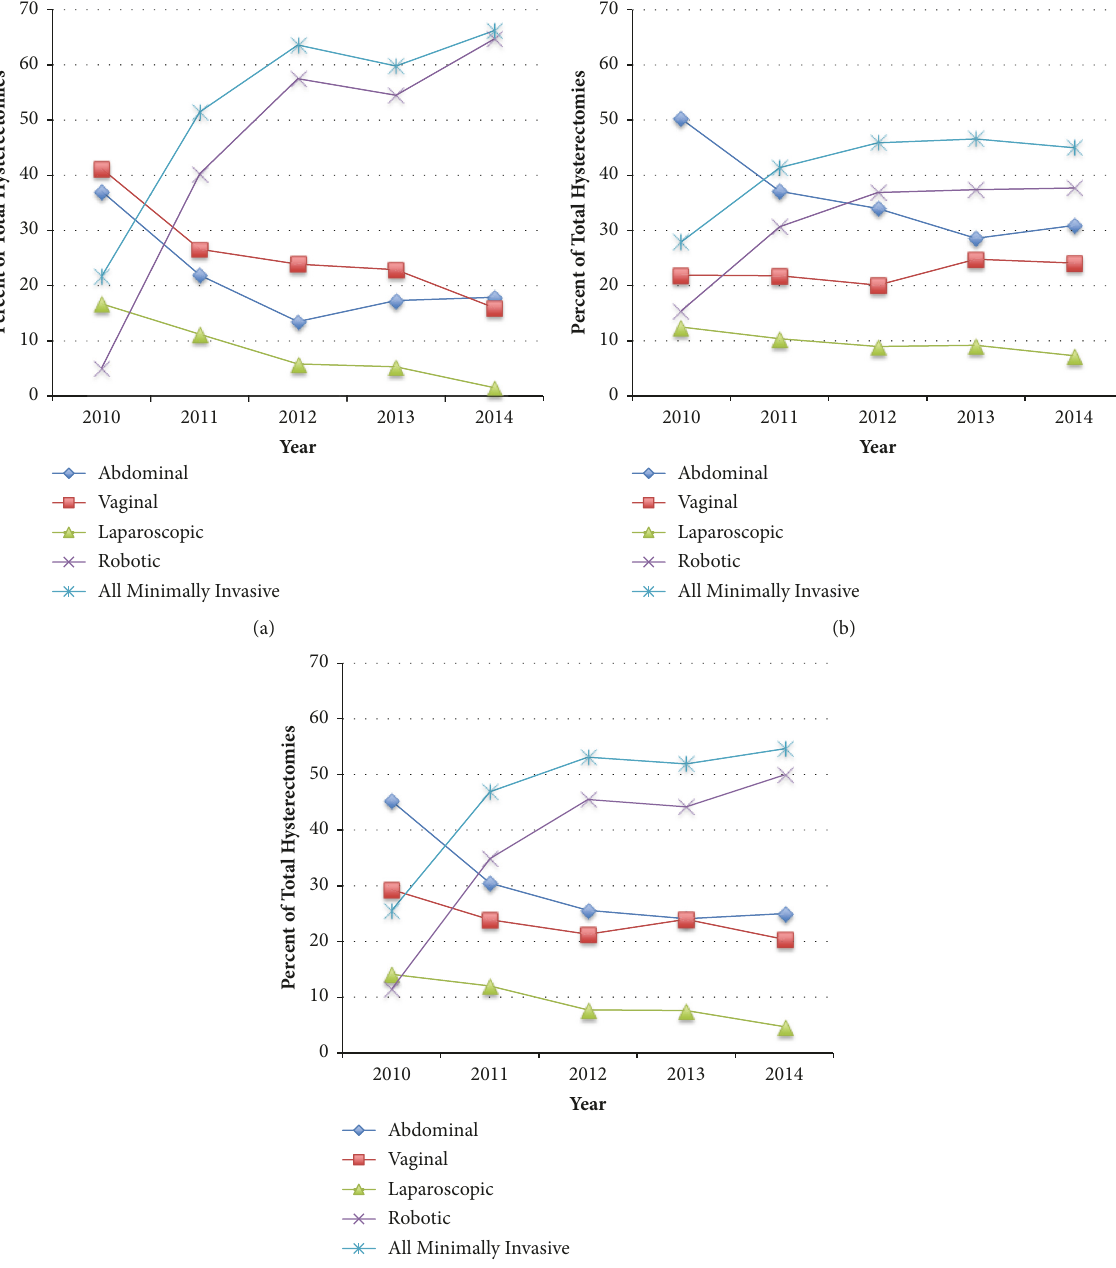
Figure 1: (a) Percent of hysterectomies by route-community hospital. (b) Percent of hysterectomies by route-teaching hospital. (c) Percent of hysterectomies by route-both